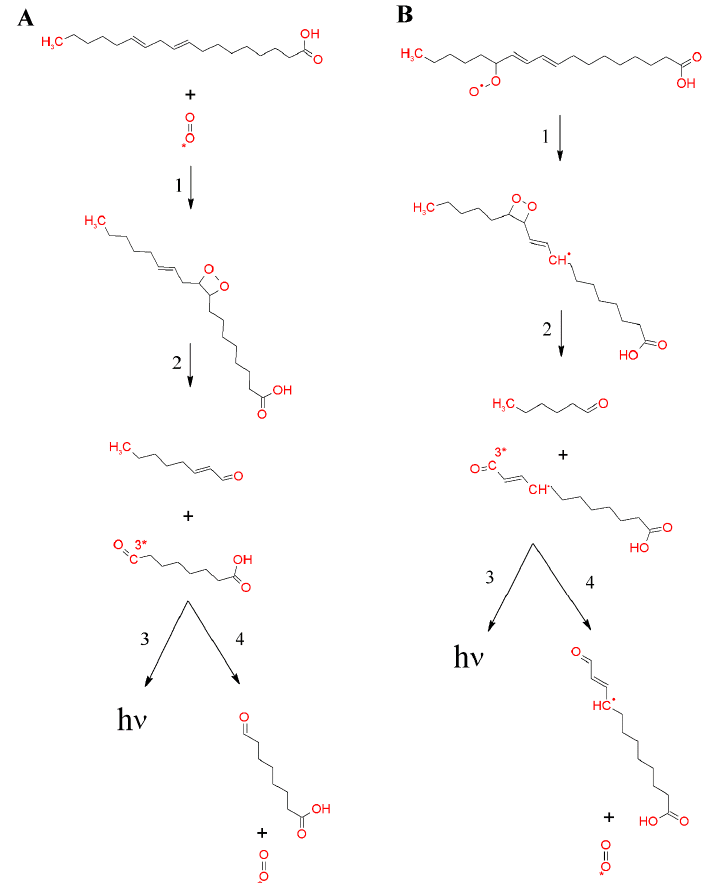
Figure 5. Formation of 1,2-dioxetane by the cycloaddition of 1 O 2 to polyunsaturated fatty acid ( A ) or the cyclisation of lipid peroxyl radicals ( B ). Formation of 1,2-dioxetane (reaction 1). 1,2-dioxetane is known to decompose into 3 R=O * and R=O (reaction 2). Subsequently, the electronic transition from 3 R=O * to R=O is associated with photon emission (reaction 3), or the energy transfer from 3 R=O * to molecular oxygen causes the formation of 1 O 2 (reaction 4).